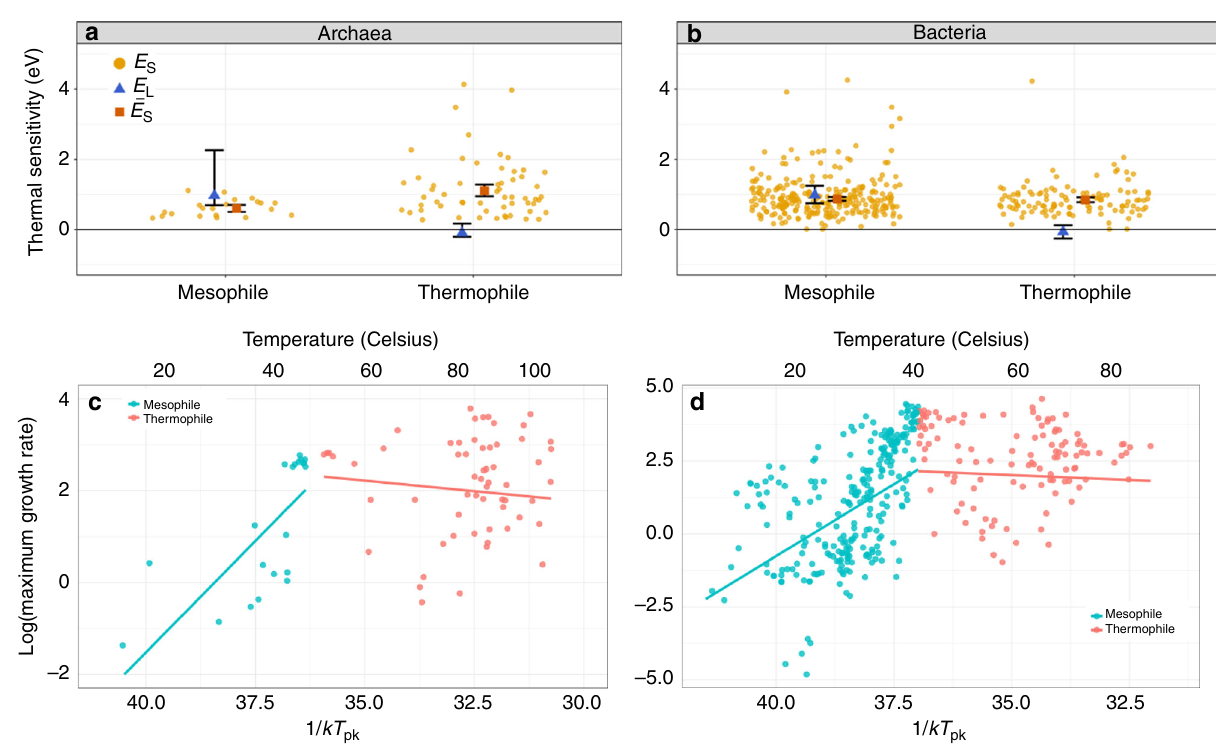
Fig. 3 Patterns of short- and long-term thermal responses of growth rate ( fi tness). a , b Activation energies (with error bars showing 95% con fi dence intervals) from Boltzmann – Arrhenius model fi ts ( E L , blue triangles) compared with mean activation energy ( E S , red squares) of the intra-speci fi c (short- is also shown (orange points). c , d Arrhenius plots ( x -axes inverted to aid visualisation) fi tted to mesophile term) thermal responses. The distribution of E S (blue) and thermophile (red) sub-groups separately within bacteria and archaea, respectively. That is, the points are the natural log of P pk ( r plotted against 1 = kT (where k is the Boltzmann constant) for each TPC, whilst the lines (the long-term thermal responses) are the Boltzmann – Arrhenius pk model fi tted using weighted regression to mesophile and thermophile data separately, after determining the break point (Methods). The HiB hypothesis is best supported for the mesophilic bacteria, whilst equalisation of fi tness is best supported in both thermophile sub-groups. The result for mesophilic archaea is less clear (Table 1). Source data are provided as a source data fi le